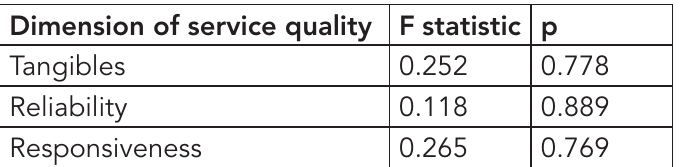
Table 4: ANOVA – Perceptions and